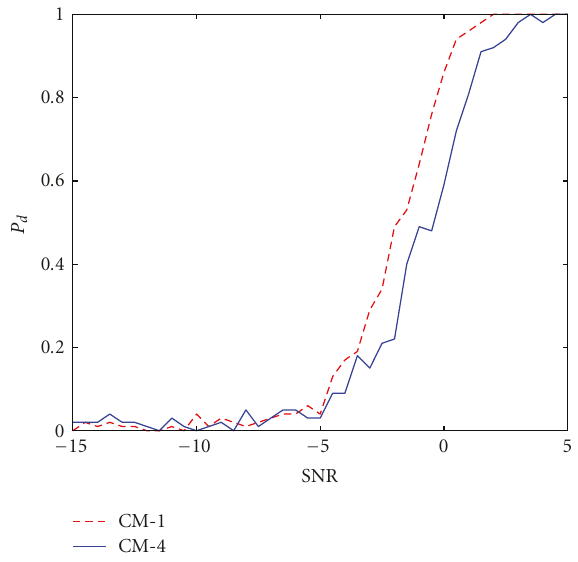
Figure 10: Probability of detection of a ZP-OFDM signal through CM-1&4 channel models with